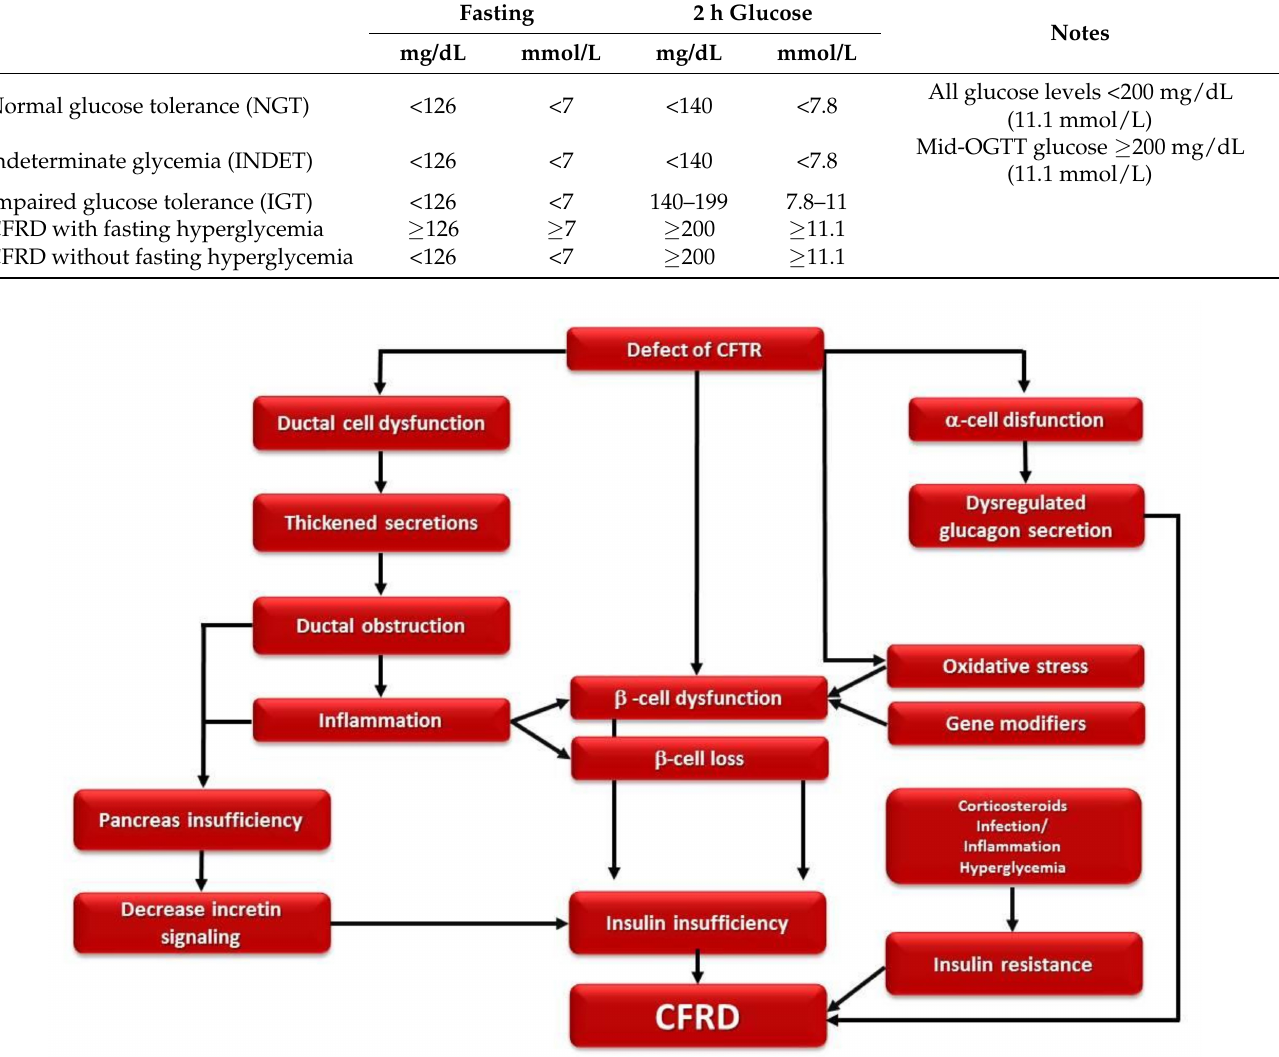
Figure 1. Diagram showing the CFRD